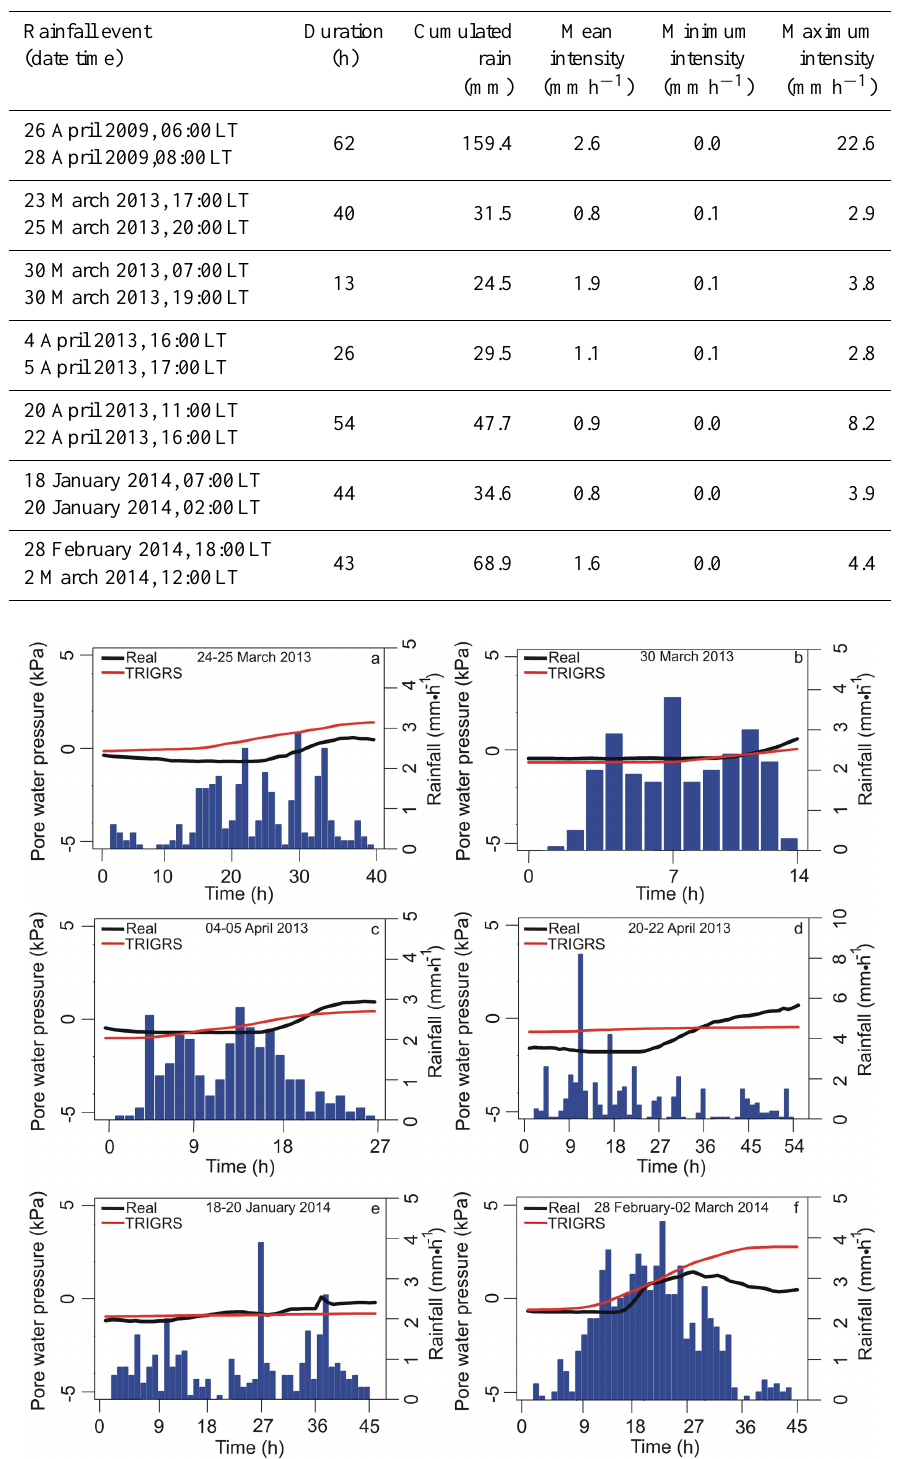
Table 6. Selected rainfall events for the implementation of TRIGRS-unsaturated features. Rainfall event Duration Cumulated Mean Minimum Maximum rain intensity intensity intensity